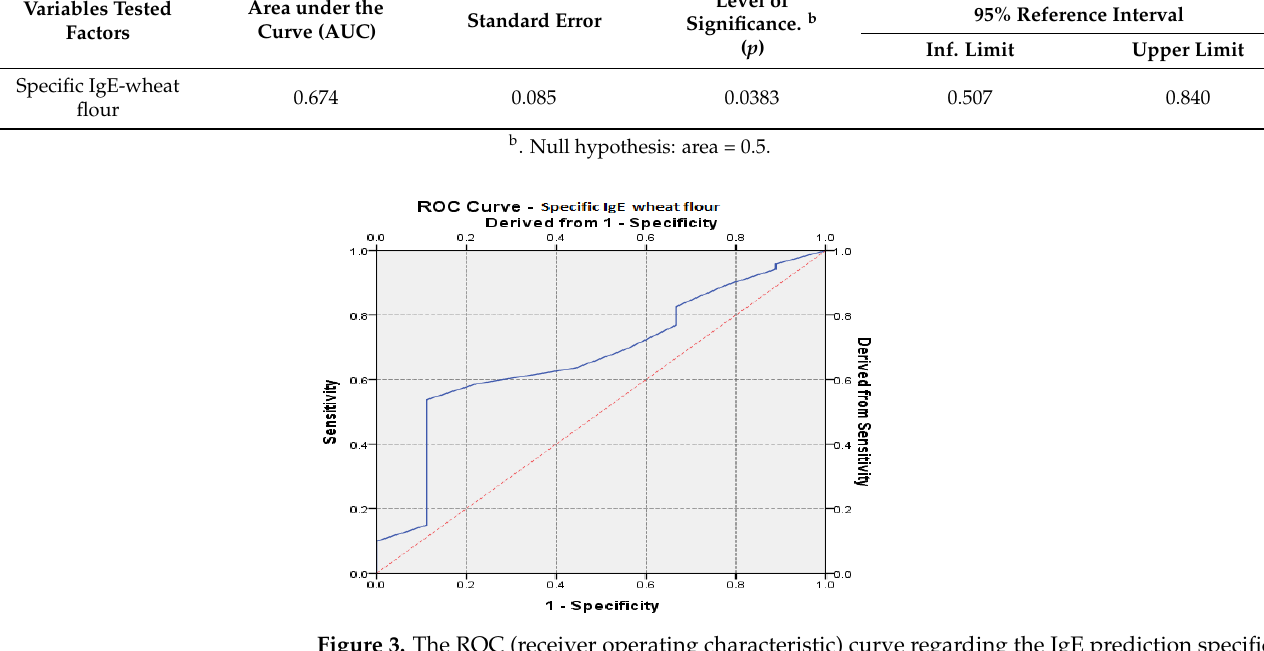
Table 2. Estimated parameters in the analysis of the ROC curve for specific IgE-wheat flour/disease remission. Area under the ROC Curve Variables Tested Factors